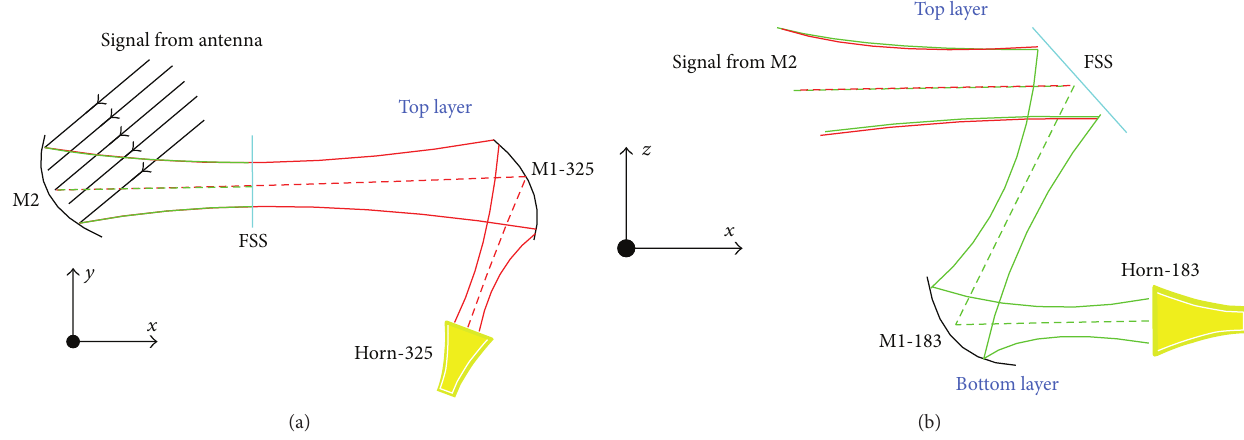
Figure 6: System layout of the 3D QON system: (a) top view of 325 GHz channel; (b) side view of 183 GHz